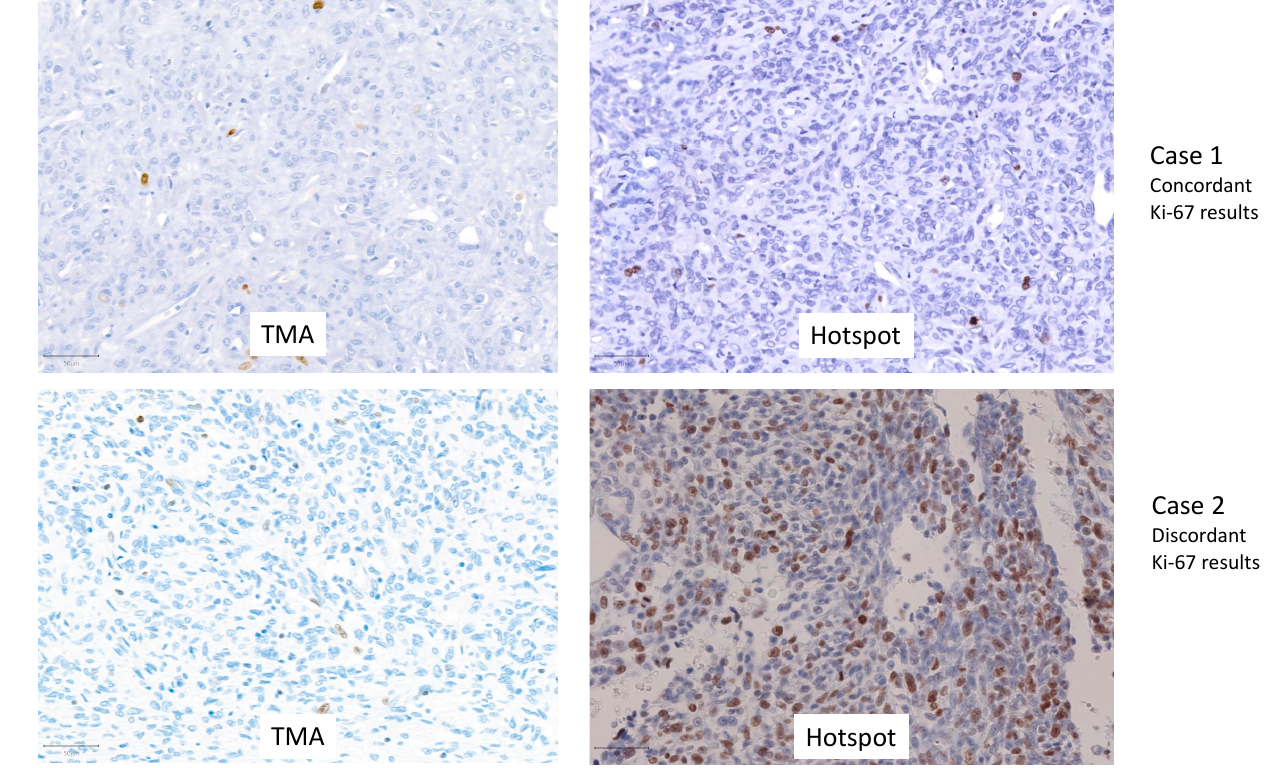
Figure 1. Ki-67 results in TMA and whole section (hotspot).